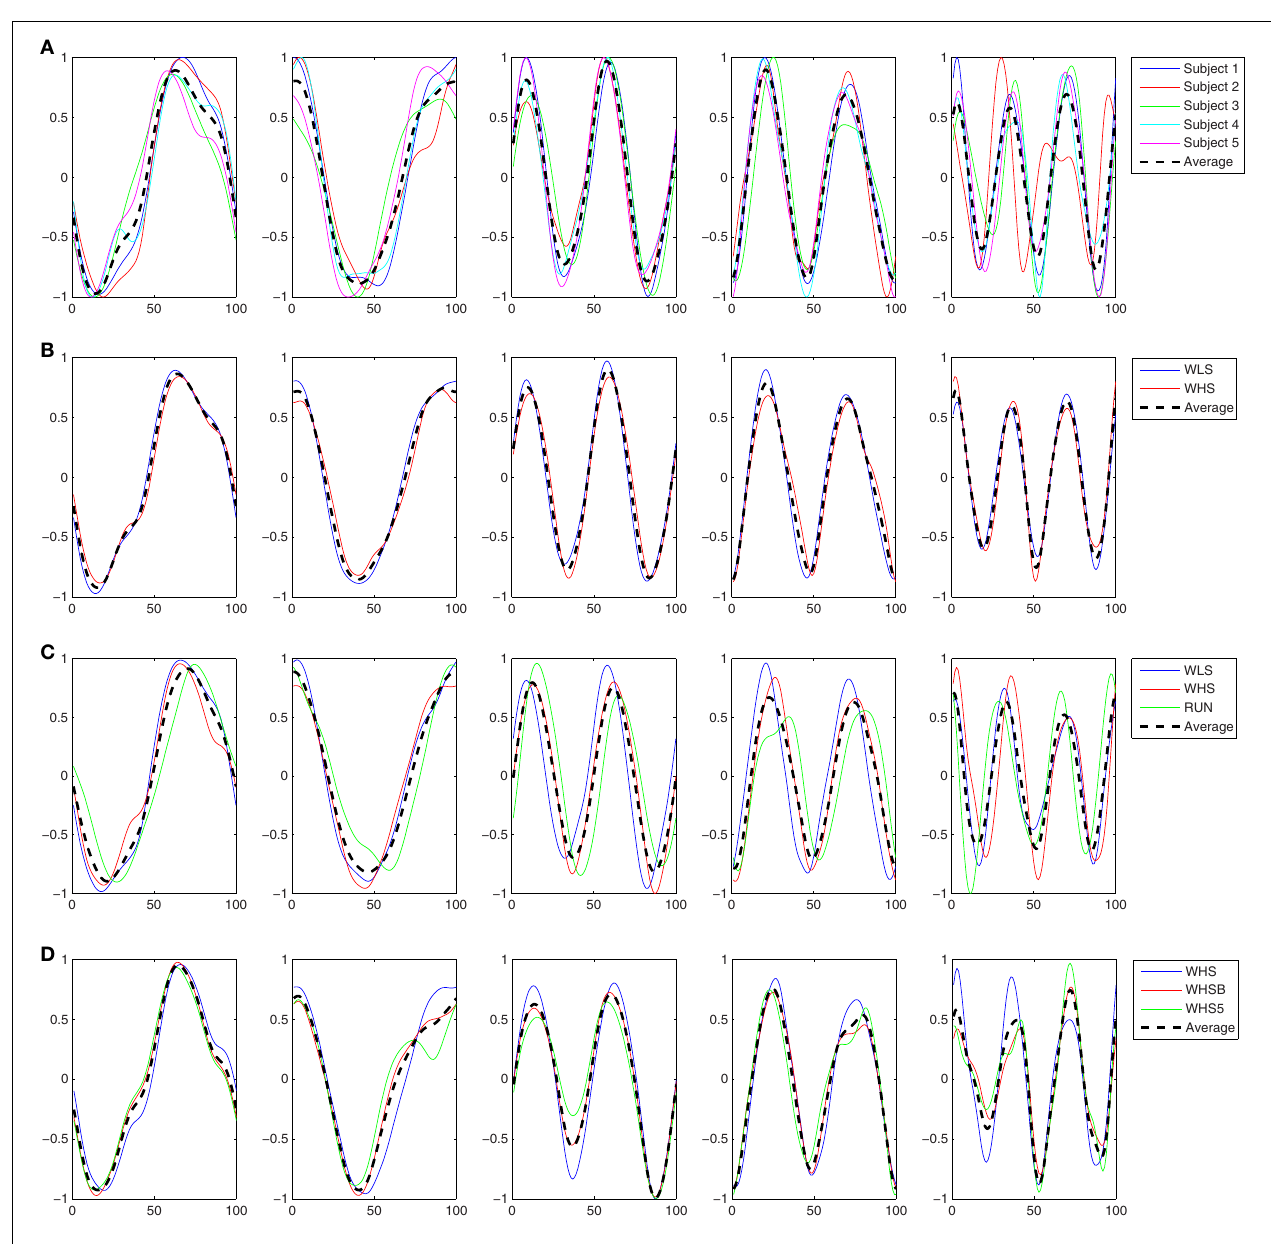
high velocity (4km/h), and running (6km/h). (D) Comparison between the average kMPs of unconstrained walking at high velocity (4km/h), and constrained (holding an empty box, and holding a 5kg load) walking at high velocity